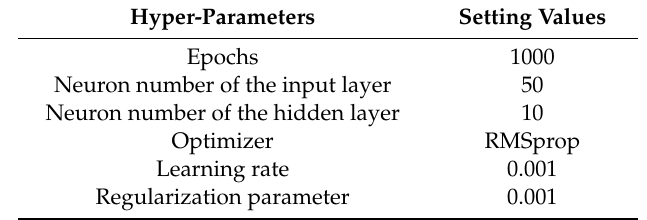
Table 2. Optimal hyper-parameters of deep neural network obtained by grid search.